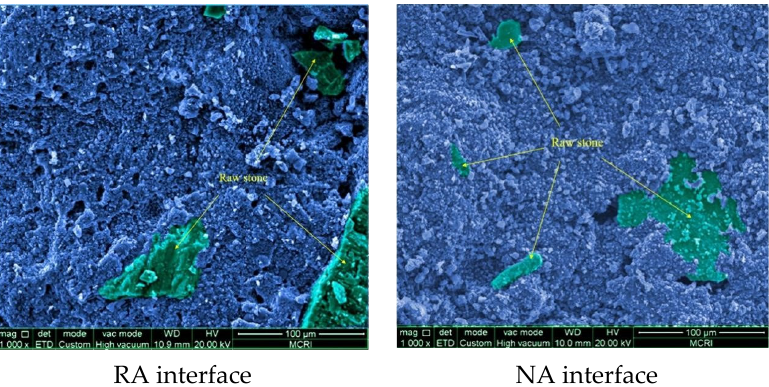
Figure 12. Comparison of repair morphology of different aggregate interfaces.